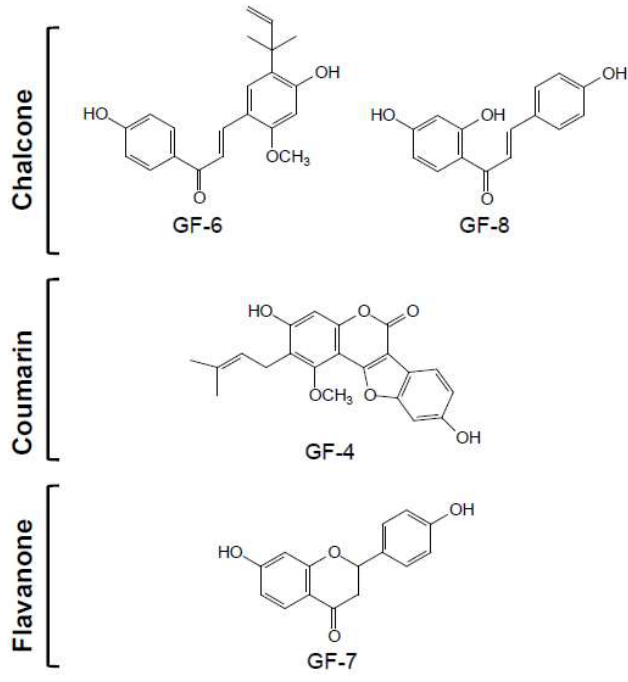
Figure 2 . Structures of flavonoids isolated from CH 2 Cl 2 extract of G. uralensis root.